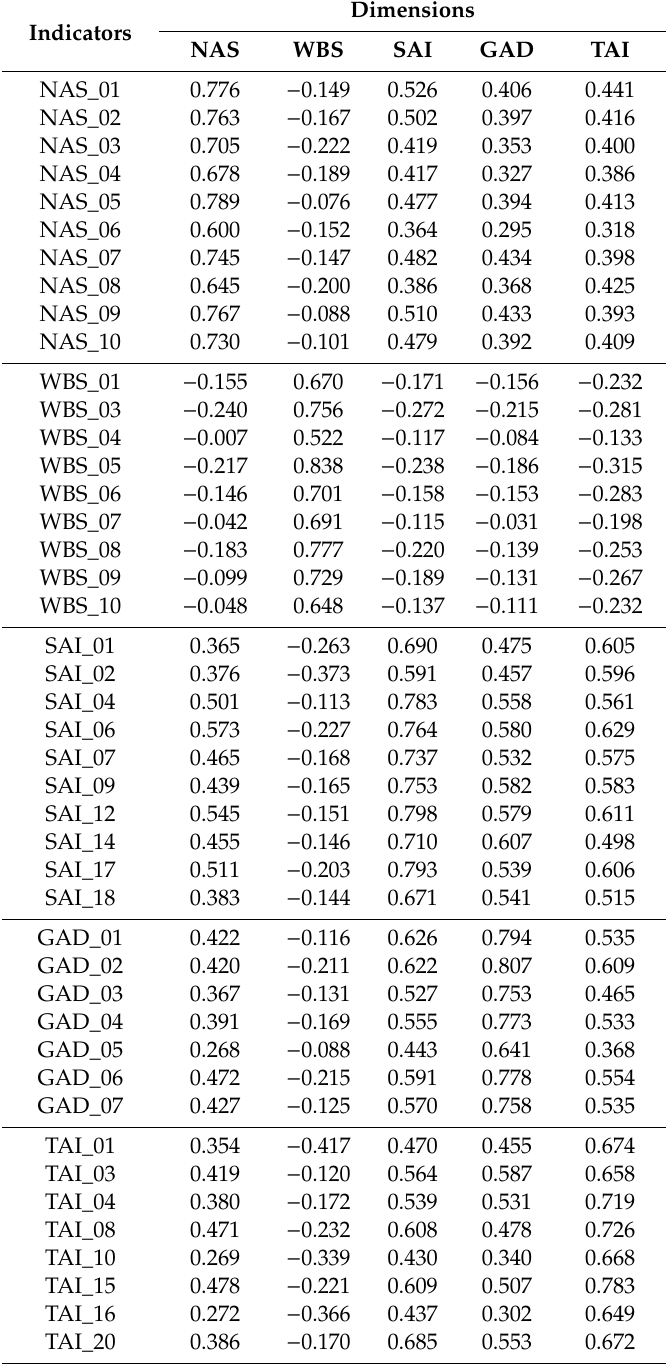
Table 7. Values of the cross-factorial loads for variables observed in the latent variables for the PANAS-GAD-7-IDATE